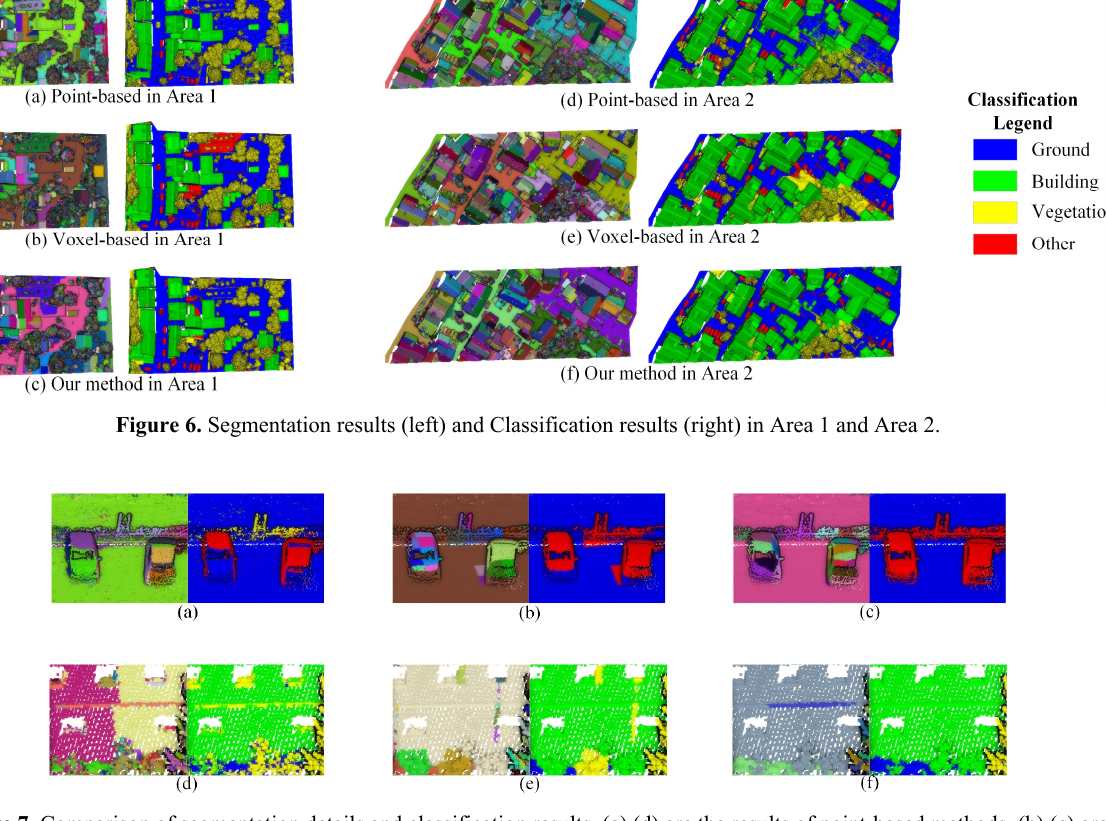
Figure 7. Comparison of segmentation details and classification results. (a) (d) are the results of point-based methods. (b) (e) are the results of voxel-based methods. (c) (f) are the results of voxel-based